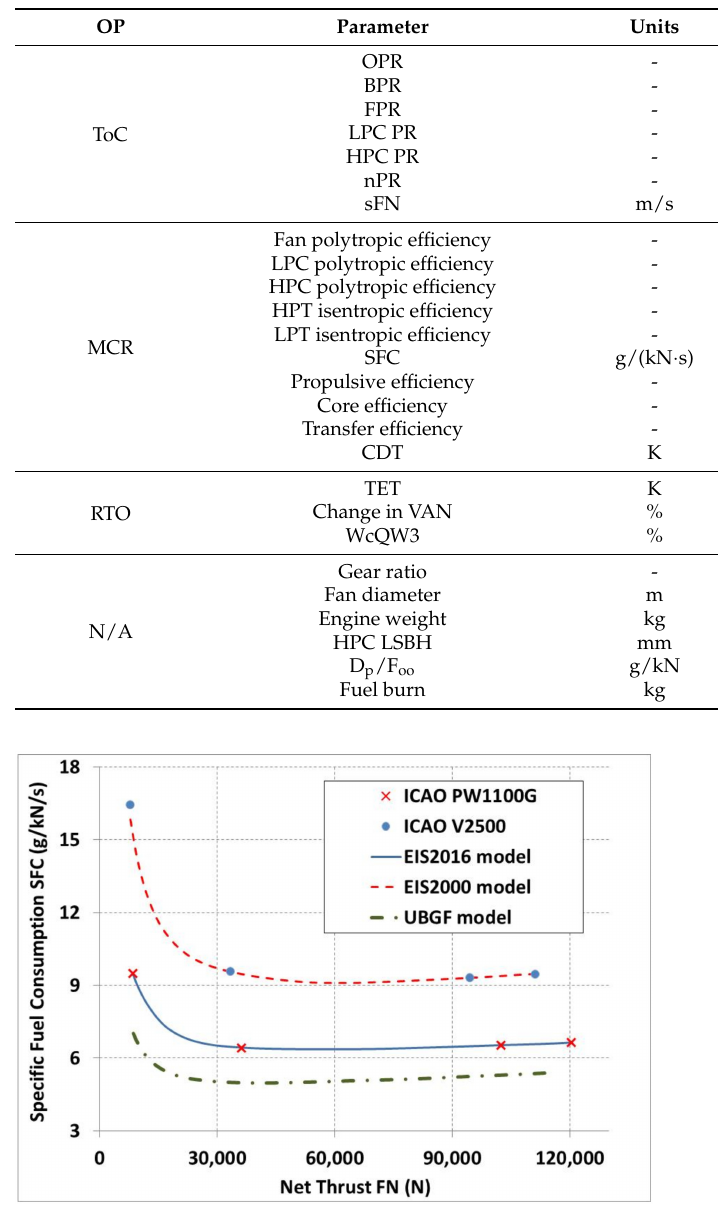
Figure 5. EIS-2000, EIS-2016 and UBGF SFC-FN variations at SLS.